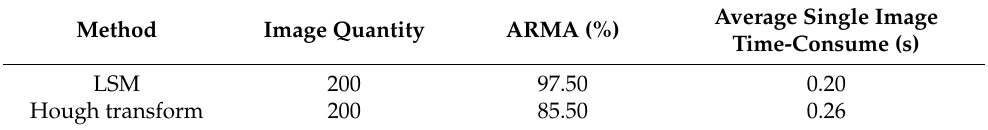
Table 6. Comparison of two line-fitting methods.